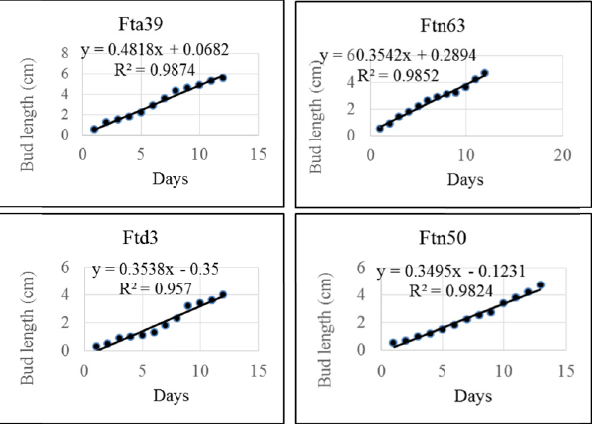
Fig. 5 5. Variation in progressive female flower bud development in four different genotypes of fluted pumpkin pollen grains are whitish and sticky. The slightly